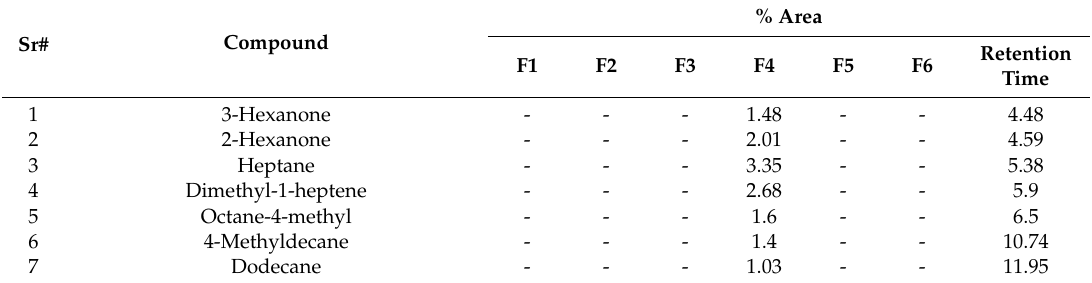
Figure 3. Major components identified in volatile oils (subfractions F1–F6) of V. betonicifolia . Table 6. Chemical composition of volatile oils (subfractions F1–F6) of V. betonicifolia .